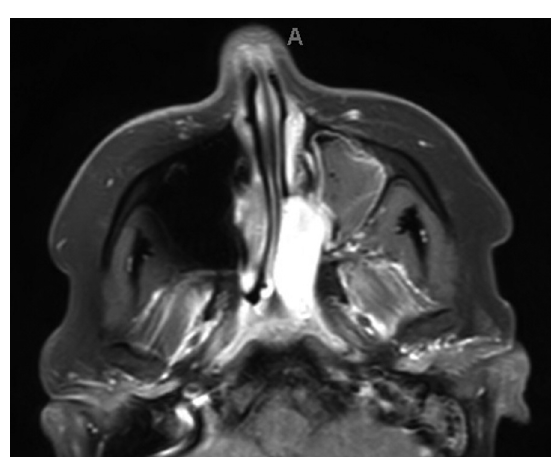
MRI, axial view, T1, Precontrast and postcontrast showing hypoin- termediate signal intensity with areas of cystic changes. Marked enhancement in the postcontrast is observed. Figure 7